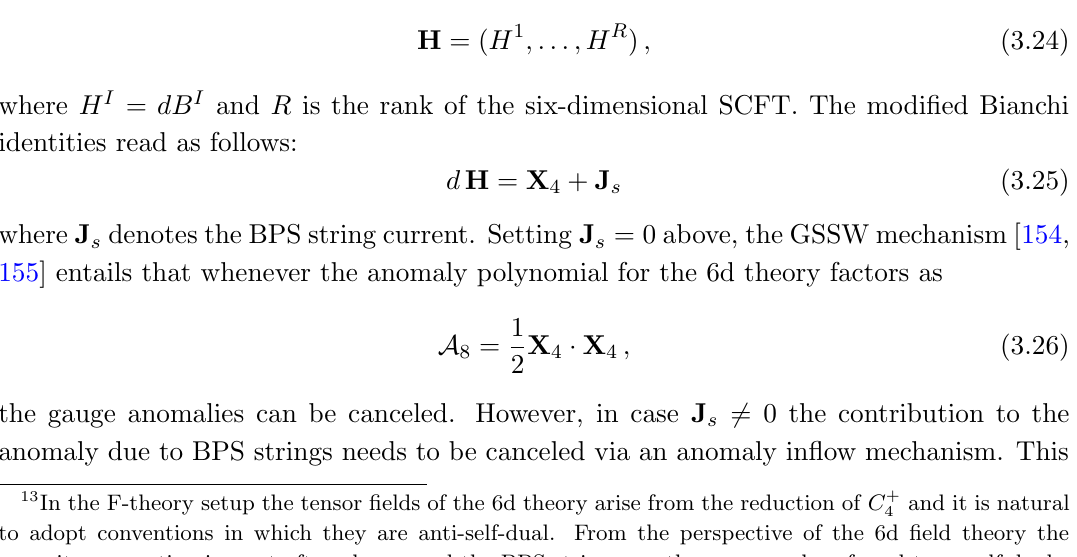
Figure 12. Geometry corresponding to a non-split singularity for the model 3 Sp(1) the folding from D 4 to G 2 in this geometry as monodromy defects for the D3 branes; in addition to this, non compact (cid:13)avor divisors give rise to matter in the 7 of G 2 localized at the intersection with the compact